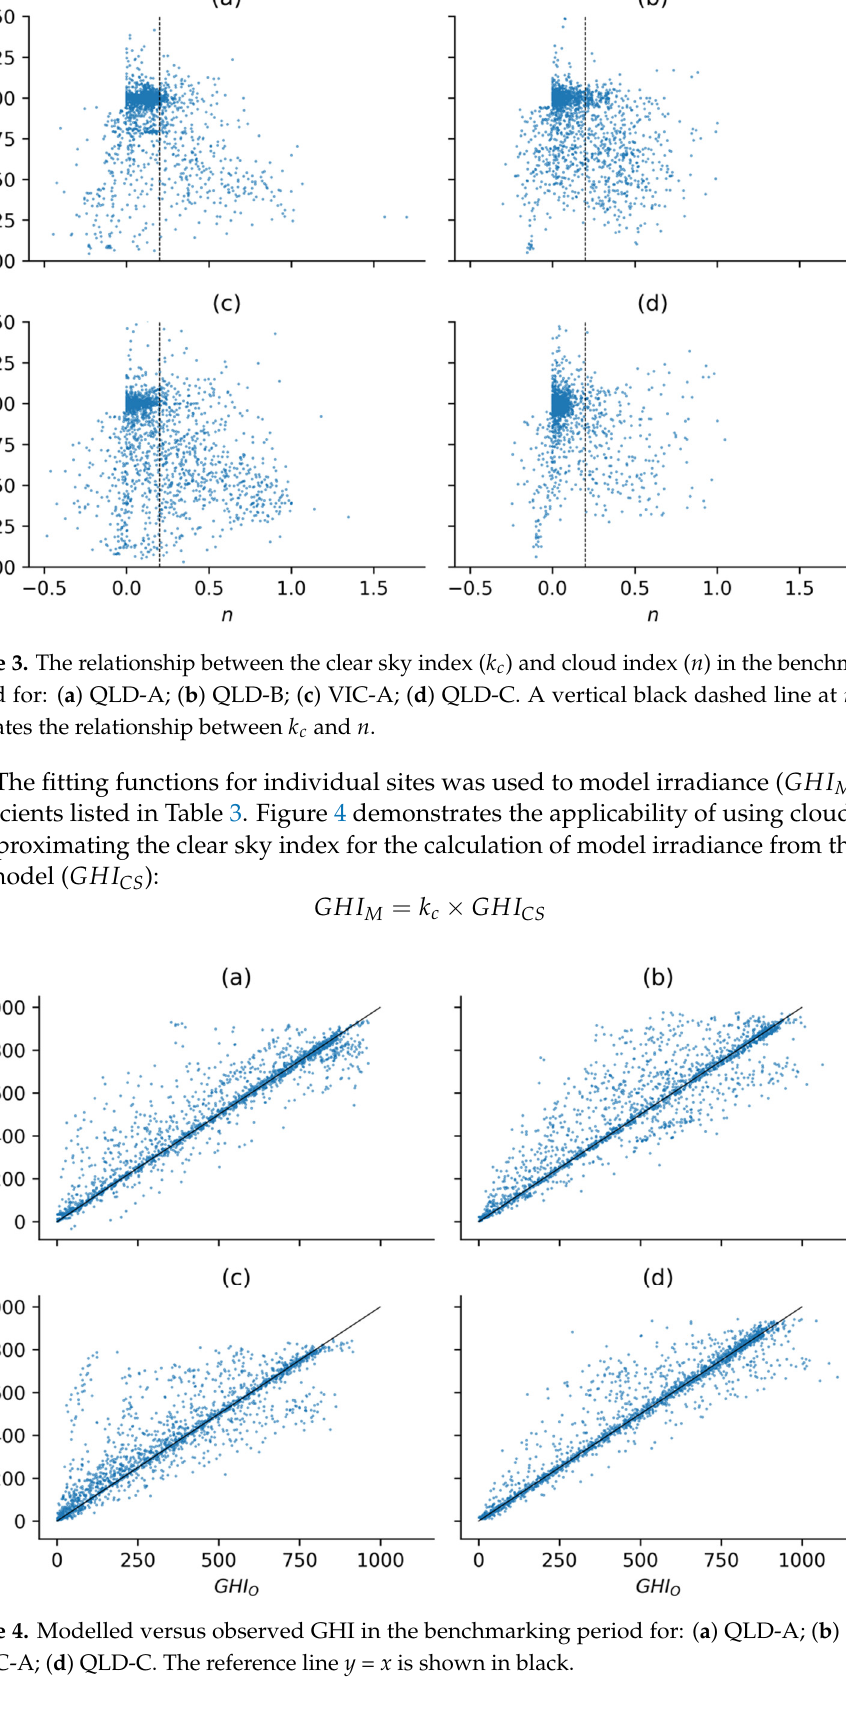
Figure 4. Modelled versus observed GHI in the benchmarking period for: ( a ) QLD-A; ( b ) QLD-B; ( c ) VIC-A; ( d ) QLD-C. The reference line y = x is shown in black.